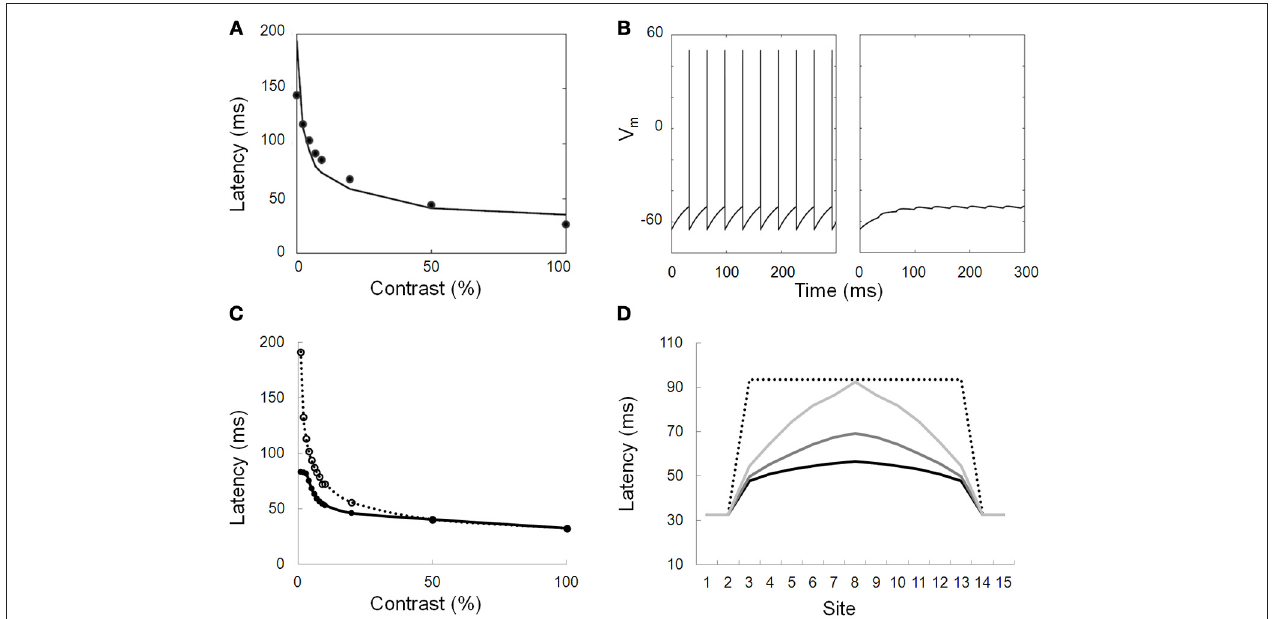
FIGURE 6 | Modeled responses of neurons. (A) Simulation of the contrast latency (first spike) response function. Dots: data from electrophysiological recordings in macaque V1 (Gawne et al., 1996). Solid line: modeled function that provides a good fit to the data. (B) Modeled response of a neuron directly stimulated by a 100% contrast stimulus (left) and of a neighboring neuron only receiving lateral inputs from the first cell through long range connections. The strength of the lateral inputs is chosen so that only subthreshold depolarizing responses are elicited. (C) Simulated response latencies of a neuron either connected to (solid line, closed symbols) or